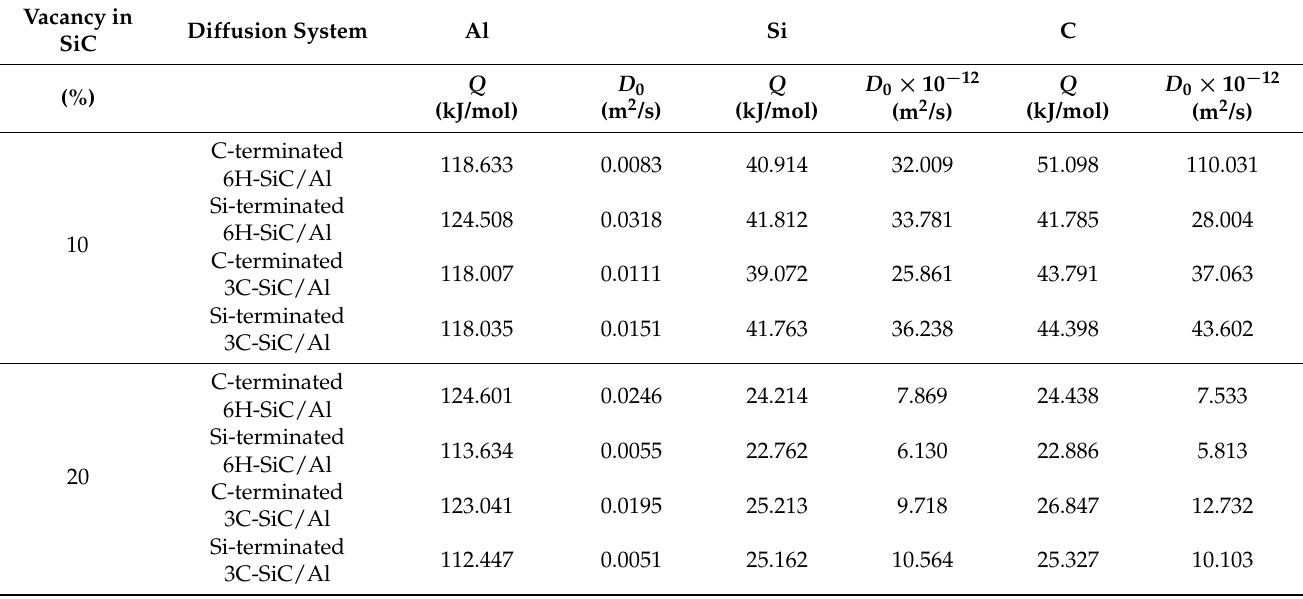
Figure 5. Arrhenius plots of Al, Si, and C atoms for the C- and Si-terminated 6H-SiC/Al and 3C-SiC/Al interfaces with ( a ) to ( c ) 10% and ( d ) to ( f ) 20% vacancy in SiC. Table 1. The self-diffusion activation energies and pre-exponential factors of Al, Si, and C for SiC/Al samples with 10% and 20% vacancy in SiC.